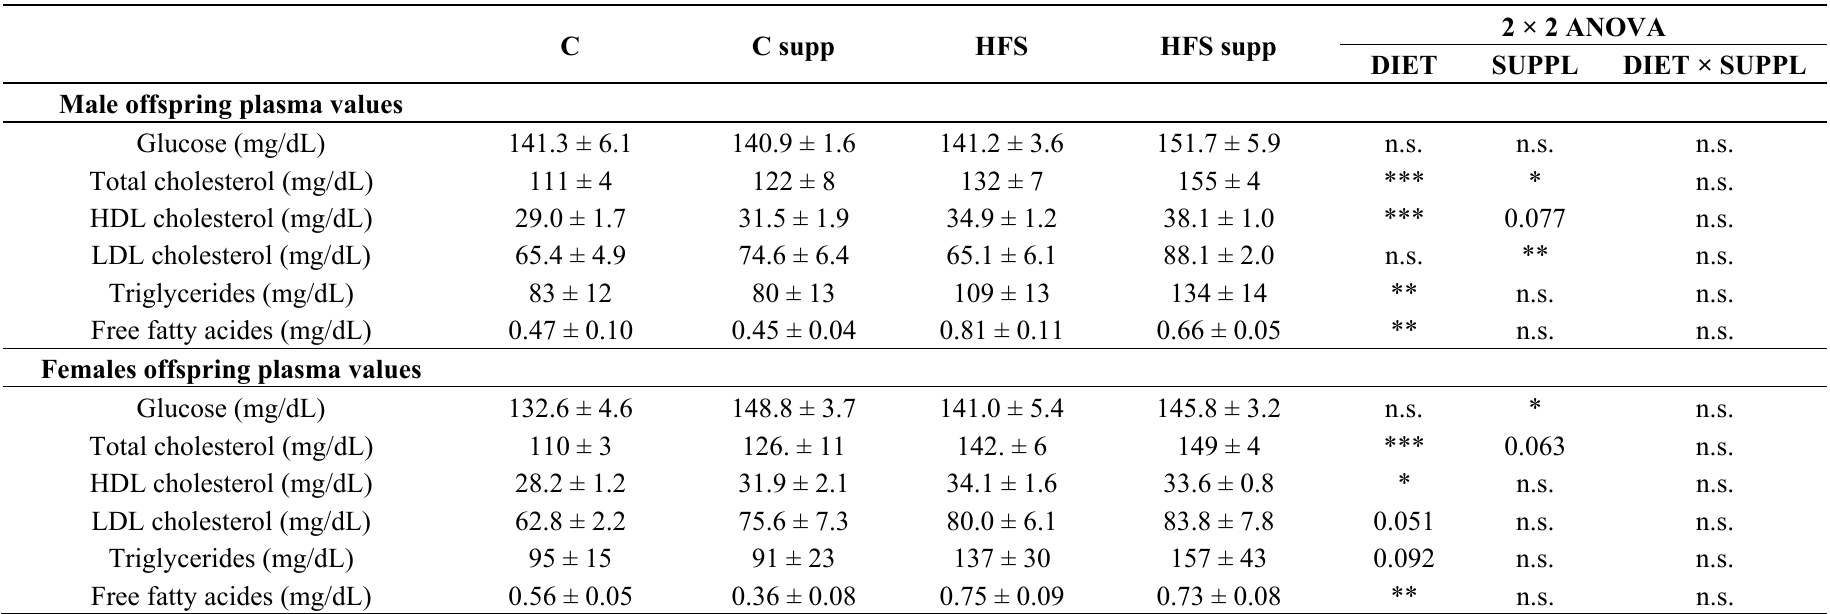
Table 2. Offspring biochemical plasma values depending on maternal nutrition during